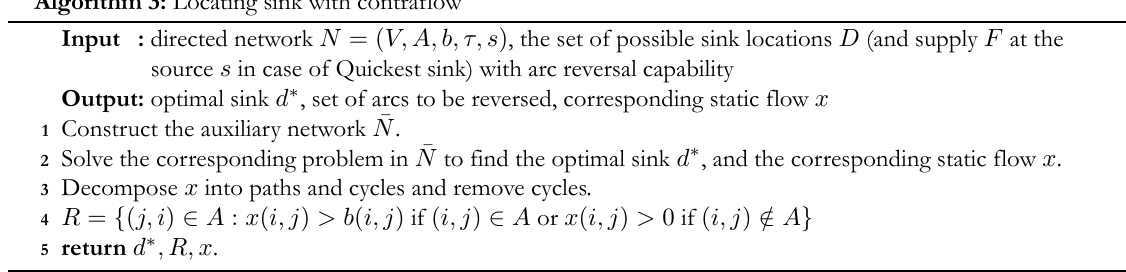
Algorithm 3: Locating sink with